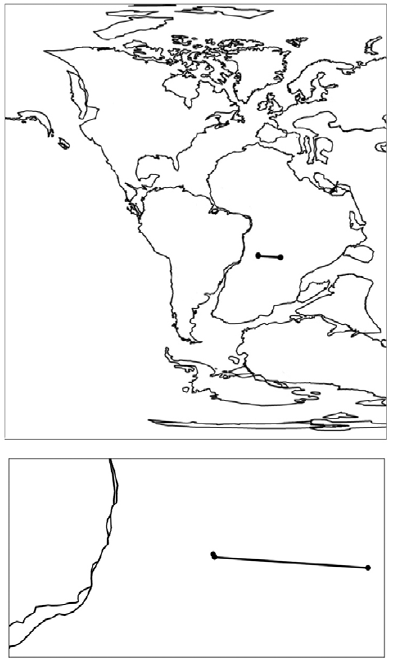
Fig. 8 - Paleogeographic map showing the individual track of Mawsonia gigas in Berriasian/Hauterivian, with a zoom of the occurrences below.